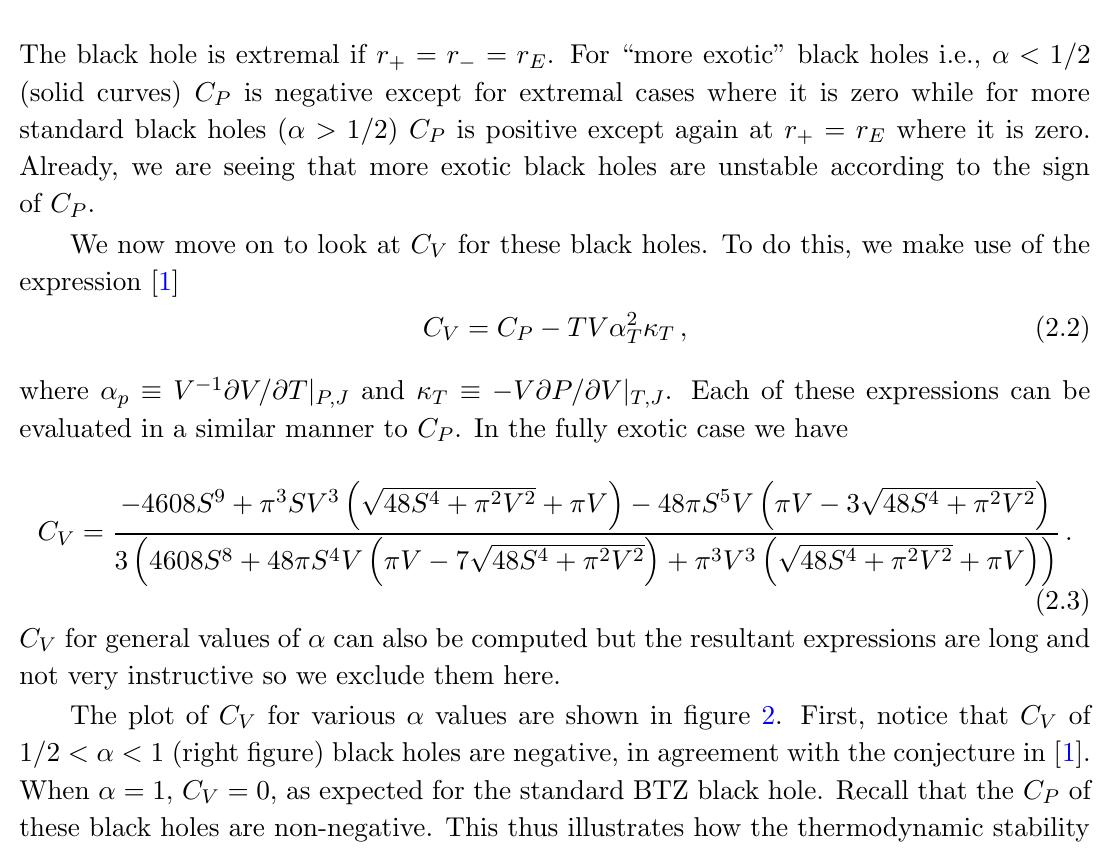
Figure 1 . Plot of C P against r + for various values of (cid:11) at P = 1 and J = 0 : 1. The range of r + in each of these plots are restricted